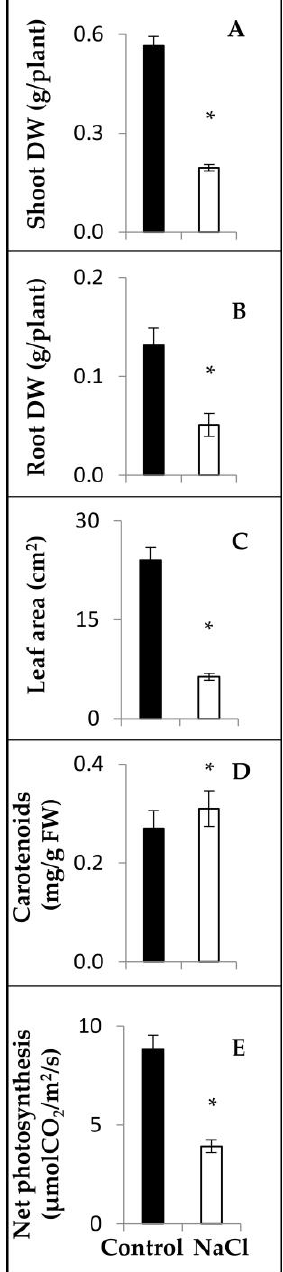
Figure 3. Effect of salinity on fertilized common bean plants. Plants of cultivar CC-25-9-N were grown under control condition (black bars) or salinity treatment (100 mM NaCl, white bars). Shoot ( A ) and root ( B ) dry weight, leaf area ( C ), carotenoids content ( D ) and net photosynthesis ( E ) were determined after 7 days of growth. Values represent the average ± SD from three biological replicates from different plant sets. Asterisks indicate significantly different means between plants grown under salinity vs. control treatments (Student’s t -test, p ≤